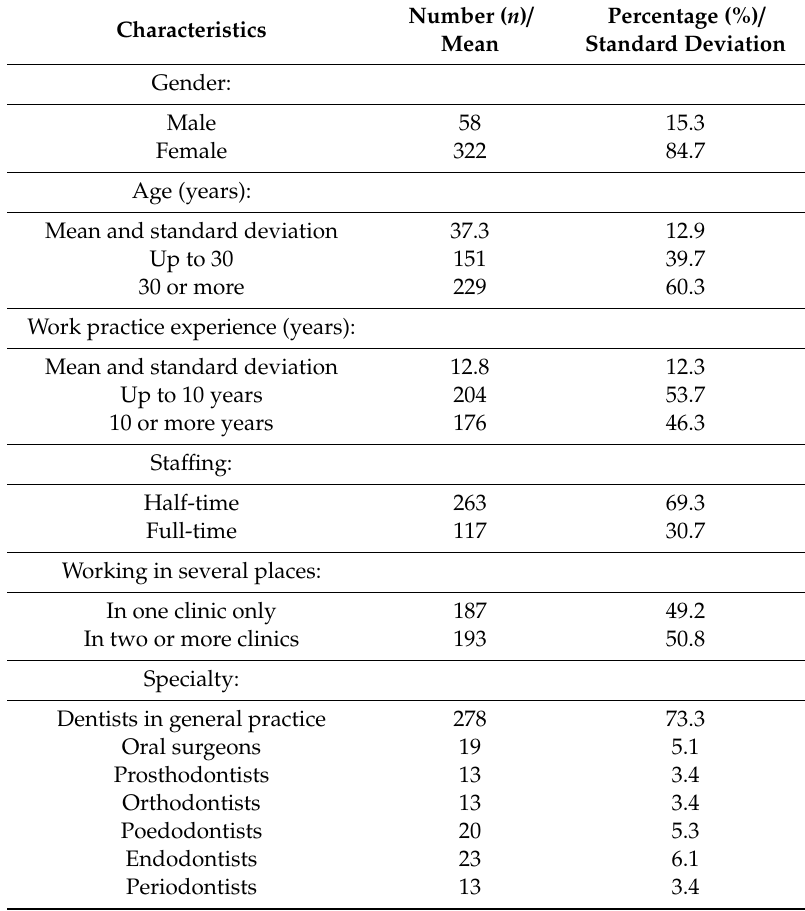
Table 1. Percentage distribution of respondents according to demographic and workload characteristics ( N =